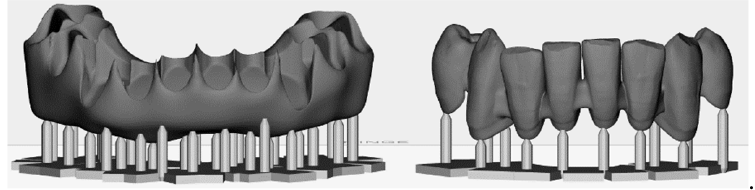
7 Figure 5. ( a ) Osteotomic and positional guide; ( b , c ) implant Guide in sagittal and coronal view. Figure 6. 3D-printing preview of the guides. 4.5. Prosthesis Once the design of the surgical guides was completed and the extent of the osteotomy was established, it was possible to design the gingival part of the temporary prosthesis. The main focus was to give the metal-free prothesis adequate thickness to guarantee the